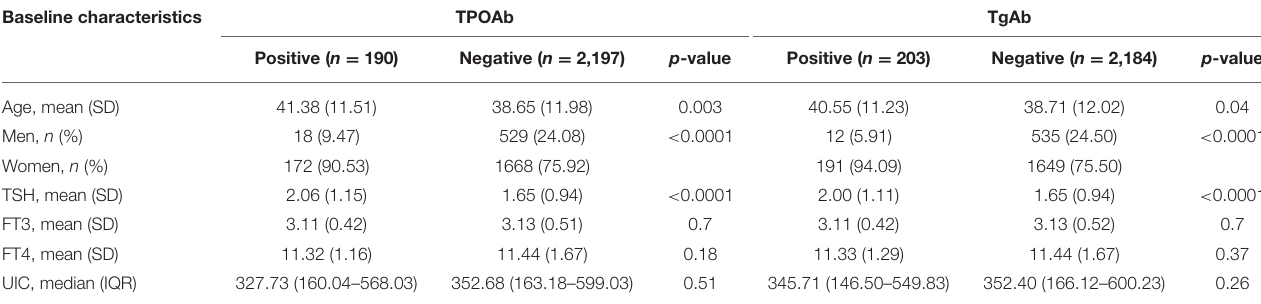
TABLE 1 | Baseline characteristics of the study participants by TPOAb and TgAb group.